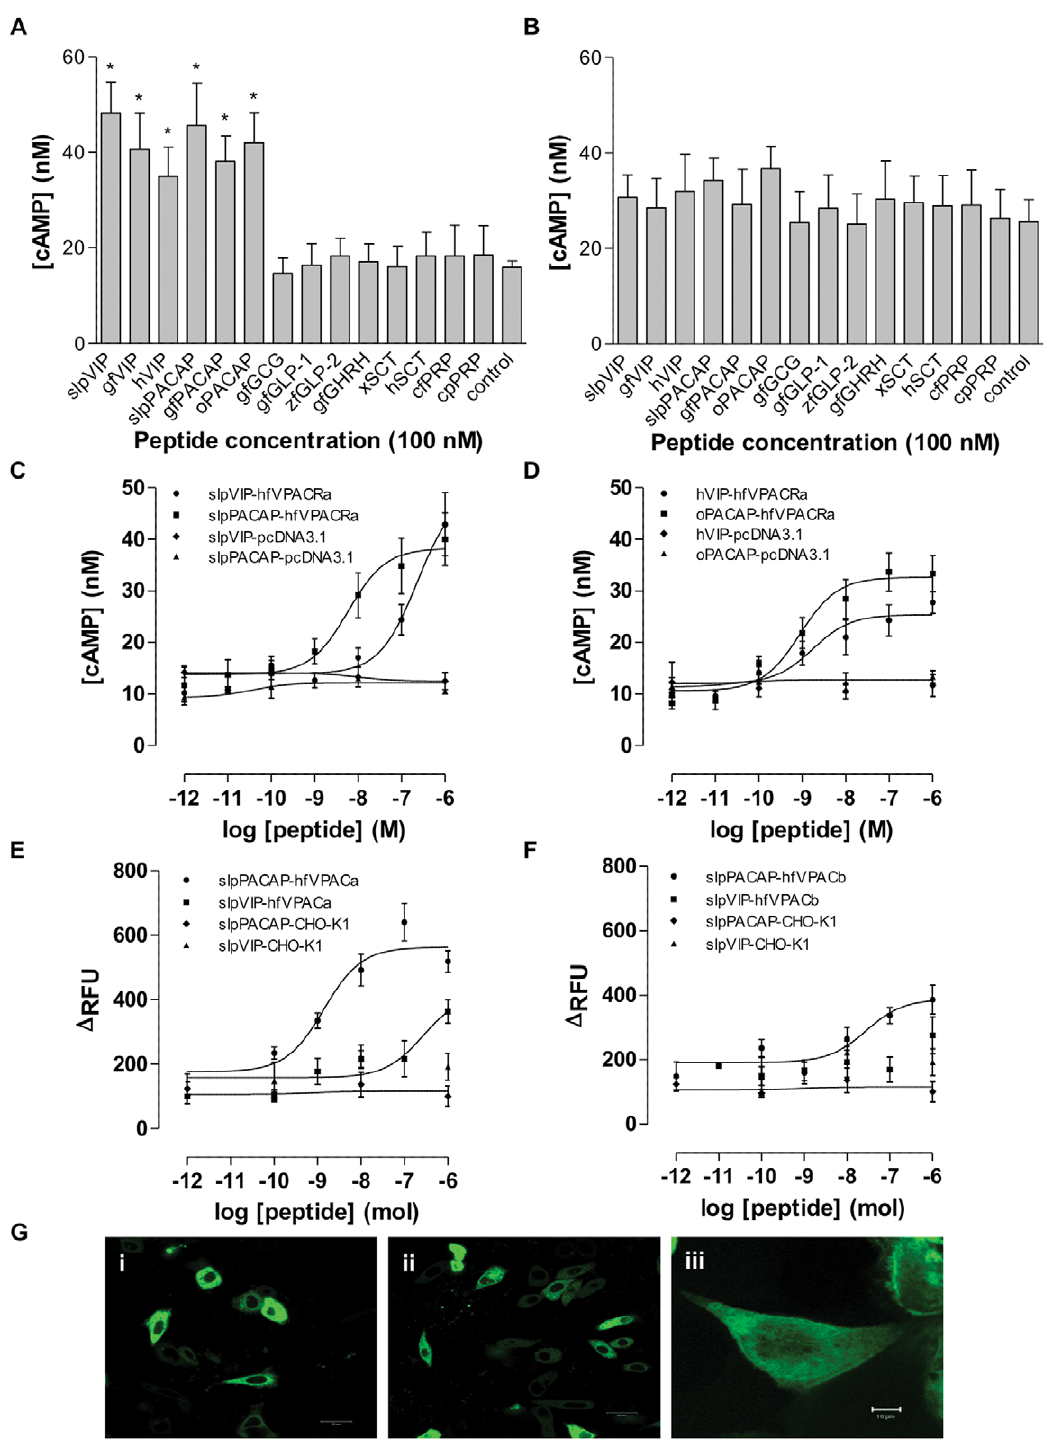
Figure 4. Functional characterization of hfVPACa and hfVPACb. Intracellular cAMP accumulation in response to 100 nM vertebrate superfamily peptides on COS-7 cells transiently transfected with (A) hfVPACa and (B) hfVPACb. Peptide species: slp, sea lamprey; gf, goldfish; h, human; o, ovine; zf, zebrafish; x, Xenopus ; ct, catfish and cp, carp. Data represent the mean 6 S.E.M. of at least 4 experiments performed in duplicates, p , 0.01 is denoted by ‘‘*’’. Effects of graded concentrations of (C) agnathan and (D) mammalian VIP and PACAP peptides on COS-7 cells transiently expressing hfVPACa. Data are expressed as the mean 6 S.E.M. of at least 6 experiments performed in duplicates. Measurement of intracellular calcium elevation in CHO-K1 cells transiently expressing (E) hfVPACa and (F) hfVPACb in response to graded concentrations of sea lamprey PACAP. Data are expressed as the mean 6 S.E.M. of at least 4 experiments. RFU, relative fluorescence units. (G) Shown are representative of confocal fluorescence images of CHO-K1 cells expressing (i) hfVPACa-pEYFP, (ii) hfVPACb-pEYFP and (iii) pEYFP-N1.